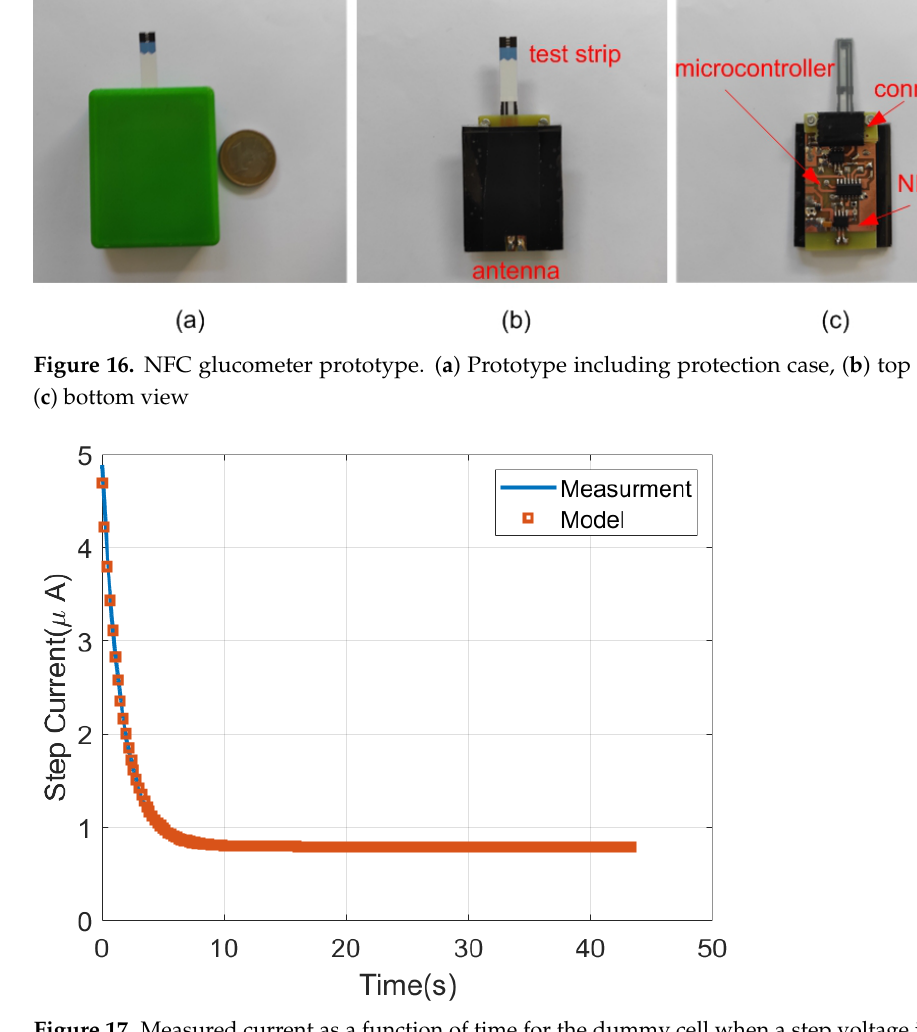
Figure 17. Measured current as a function of time for the dummy cell when a step voltage is